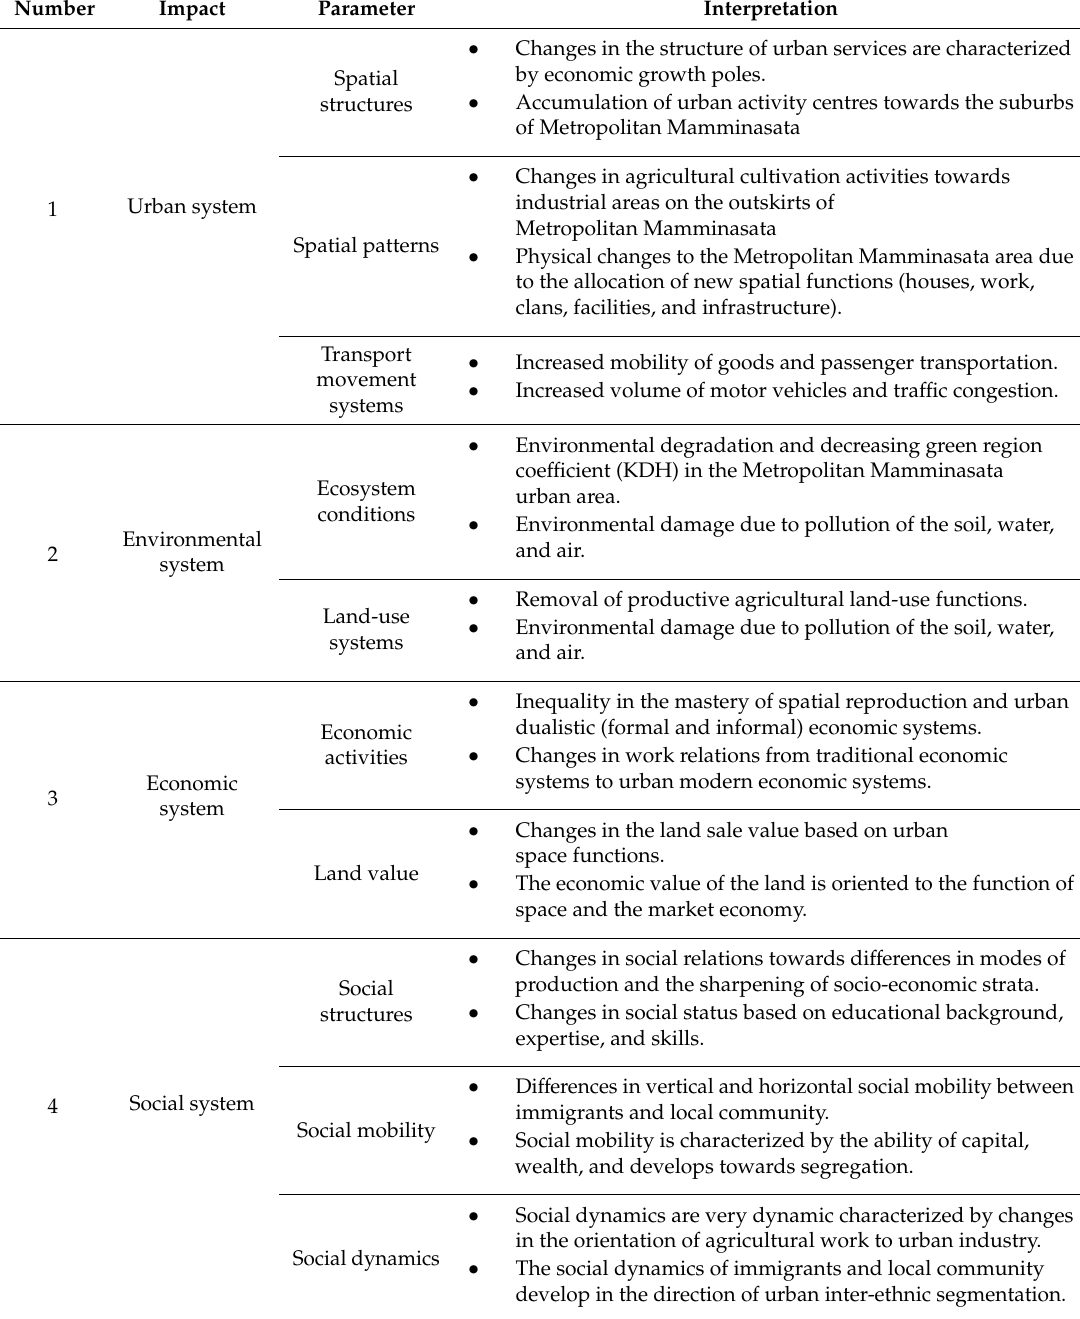
Table 2. Impact of spatial transformation in the new city area of Metro Tanjung